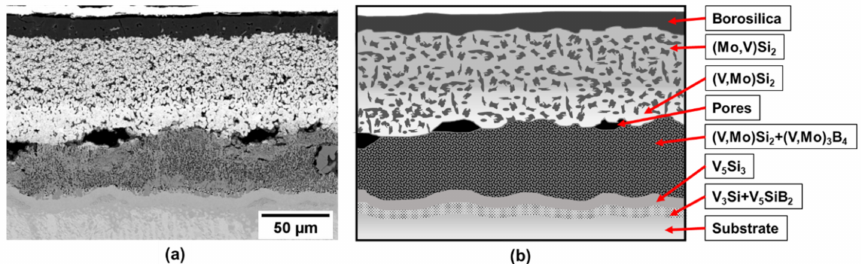
Figure 5. ( a ) Coating structure on a V-9Si-5B alloy after exposure at 1100 ◦ C for 10 h and ( b ) schematic illustration of the coating structure.